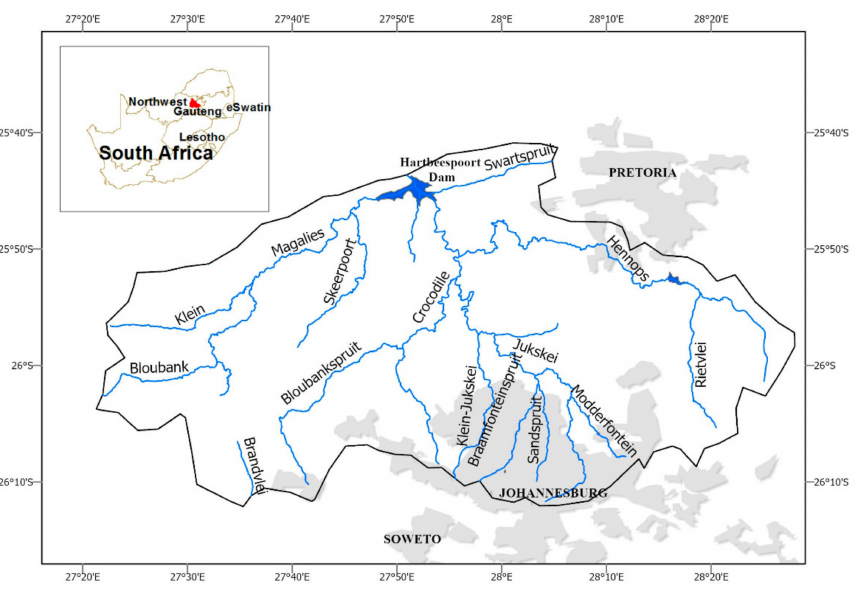
Figure 1. Map of the Hartbeespoort Dam and its watershed with drainage system indicated by